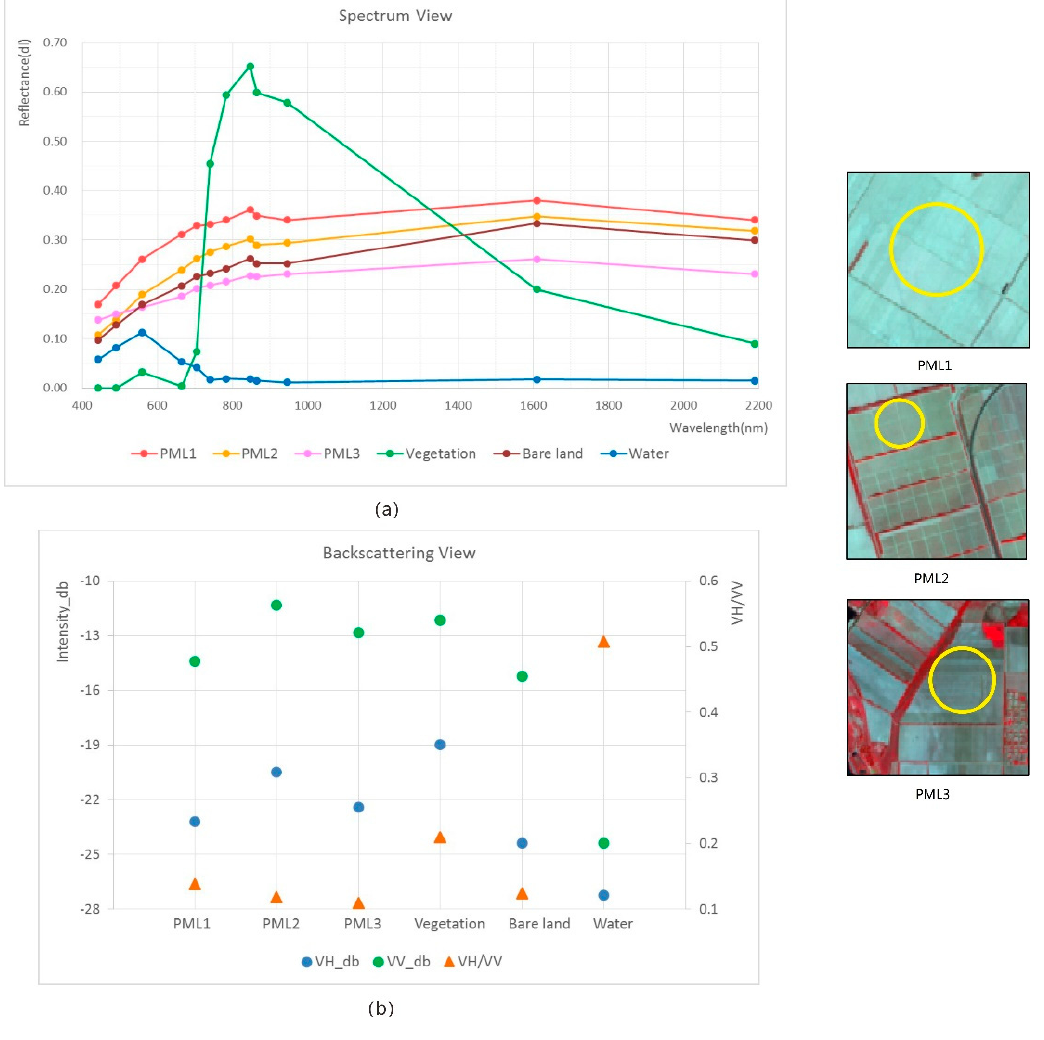
Figure 3. The spectrum and backscattering information from Sentinel-1 and Sentinel-2 with different plastic-mulched landcover (PML). ( a ) The spectrum view from Sentinel-2; ( b ) The backscattering view from Sentinel-1.